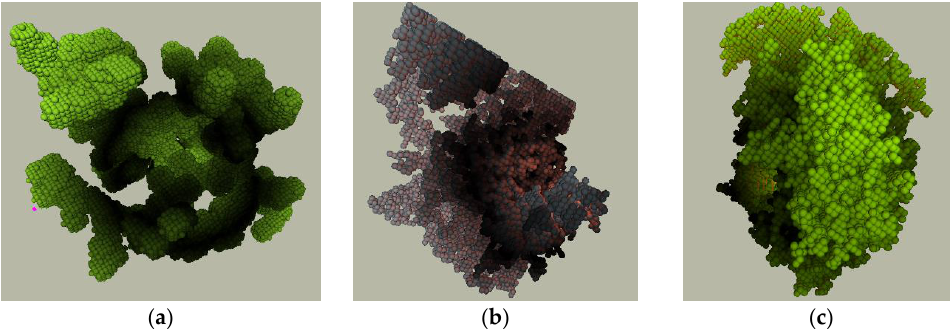
Figure 7. Generated structures of aluminosilicate catalysts with ( a ) 250, ( b ) 500, and ( c ) 700 m 2 /g specific surface area.